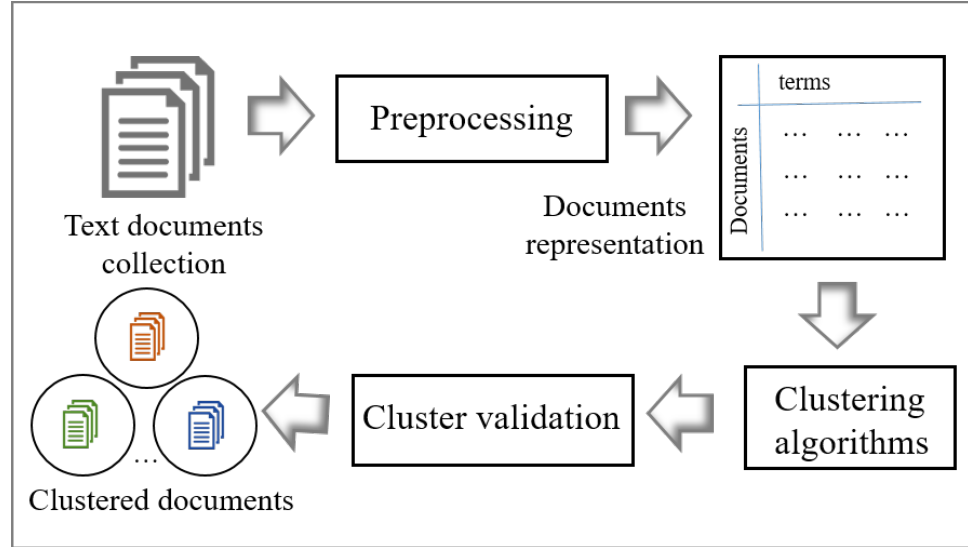
Figure 1. The Process of Text Document Clustering